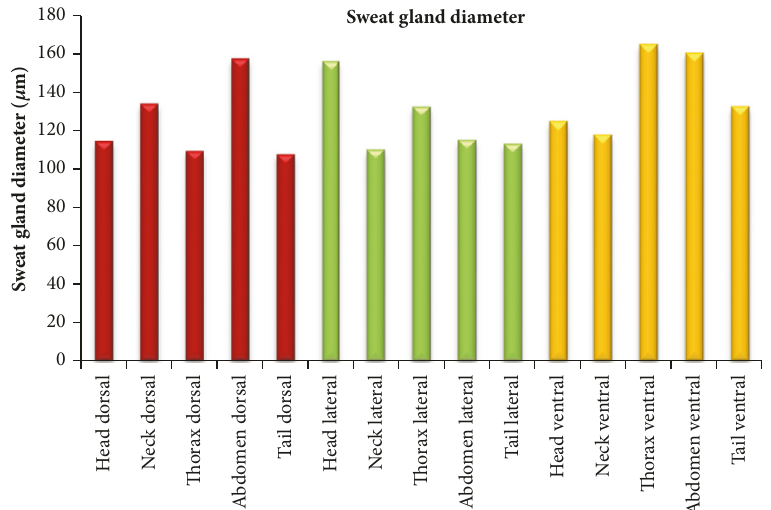
Figure 4: Graph showing a comparison of diameter of sweat glands in different areas of body